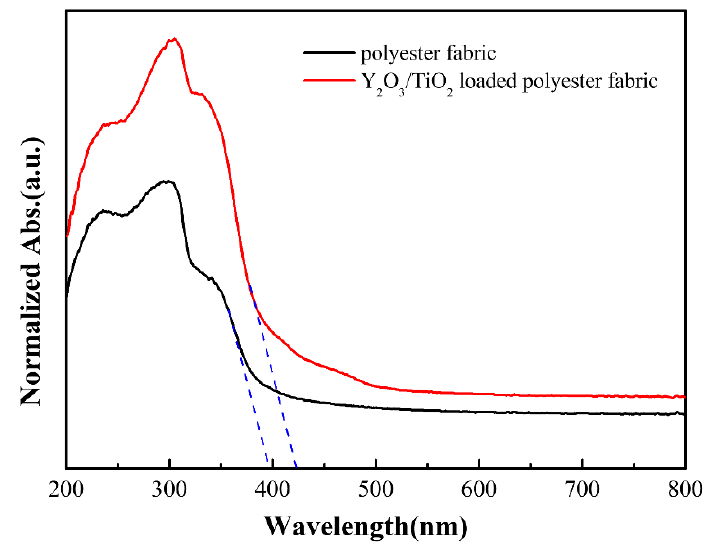
Figure 10. UV – Visible absorption spectrum of the photocatalytic materials. Figure 10. UV–Visible absorption spectrum of the photocatalytic